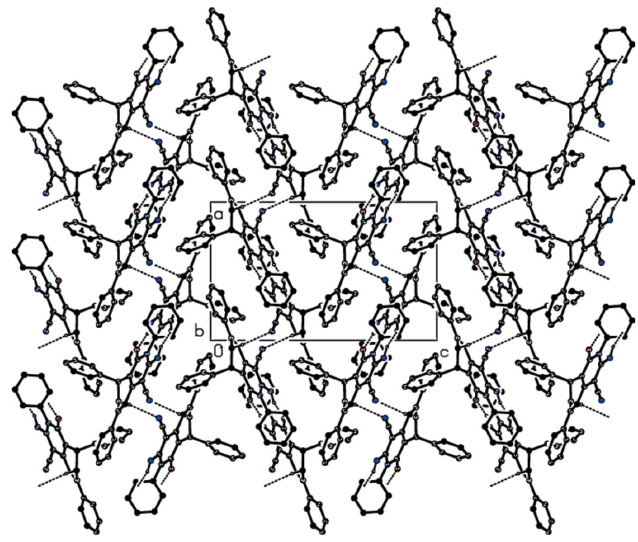
Figure 2 A view of the intermolecular N—H (cid:3)(cid:3)(cid:3) O and C—H (cid:3)(cid:3)(cid:3) N hydrogen bonds of the title compound down the b axis. H atoms not involved in hydrogen bonding have been omitted for